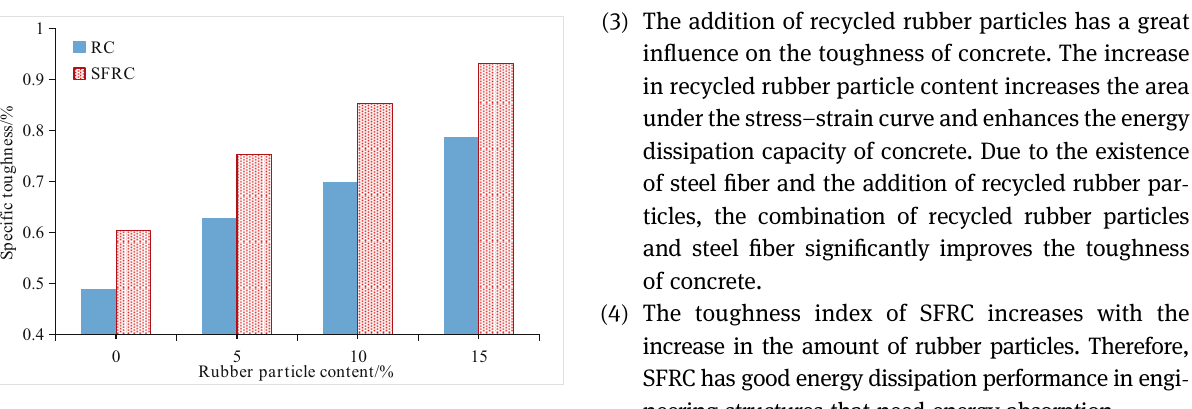
Figure 15: Speci fi c toughness of di ff erent concrete mix